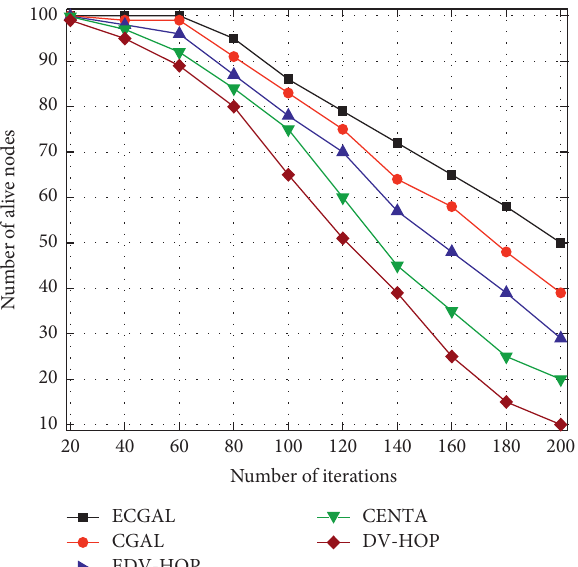
Figure 16: The number of alive nodes against the number of nodes.